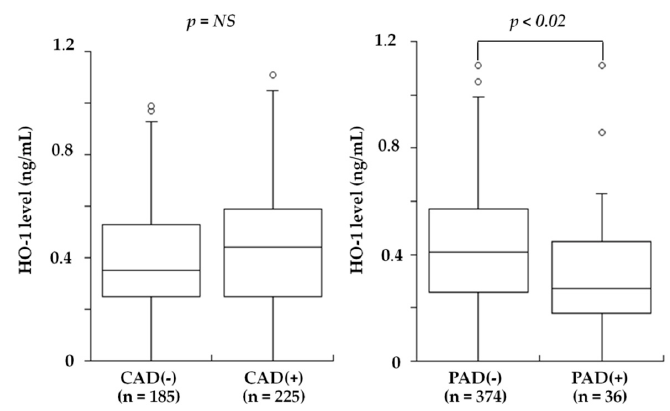
Figure 2. Plasma HO-1 levels and the presence of CAD or PAD. Plasma HO-1 levels tended to be higher in patients with CAD than in CAD(-) (median 0.44 versus 0.35 ng / mL), but this difference did not reach statistical significance ( left ). In contrast, HO-1 levels were significantly lower in patients with PAD than in PAD(-) (0.27 versus 0.41 ng / mL, p < 0.02) ( right ). The central line represents the median, and the box represents the 25th to 75th percentiles. The whiskers represent the lowest and highest value in the 25th percentile minus 1.5 IQR and 75th percentile plus 1.5 IQR, respectively. (Modified by Kishimoto et al.